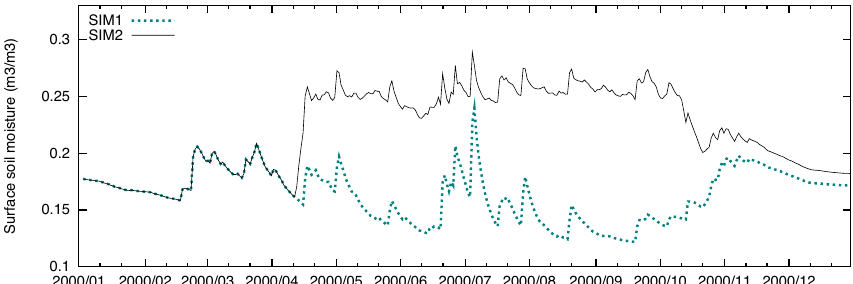
Figure 2. Surface soil moisture time series for the year 2000 from two simulations of a land surface model: (1) a free-running model simulation with the NLDAS-2 forcing (SIM1), and (2) a seasonal irrigation scheme simulated on top of SIM1